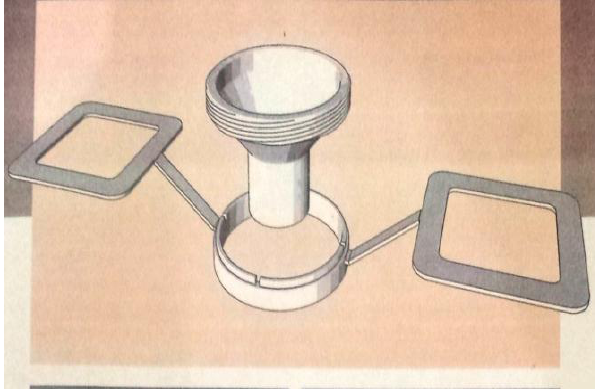
Figura 13. Haste e encaixe do suporte.